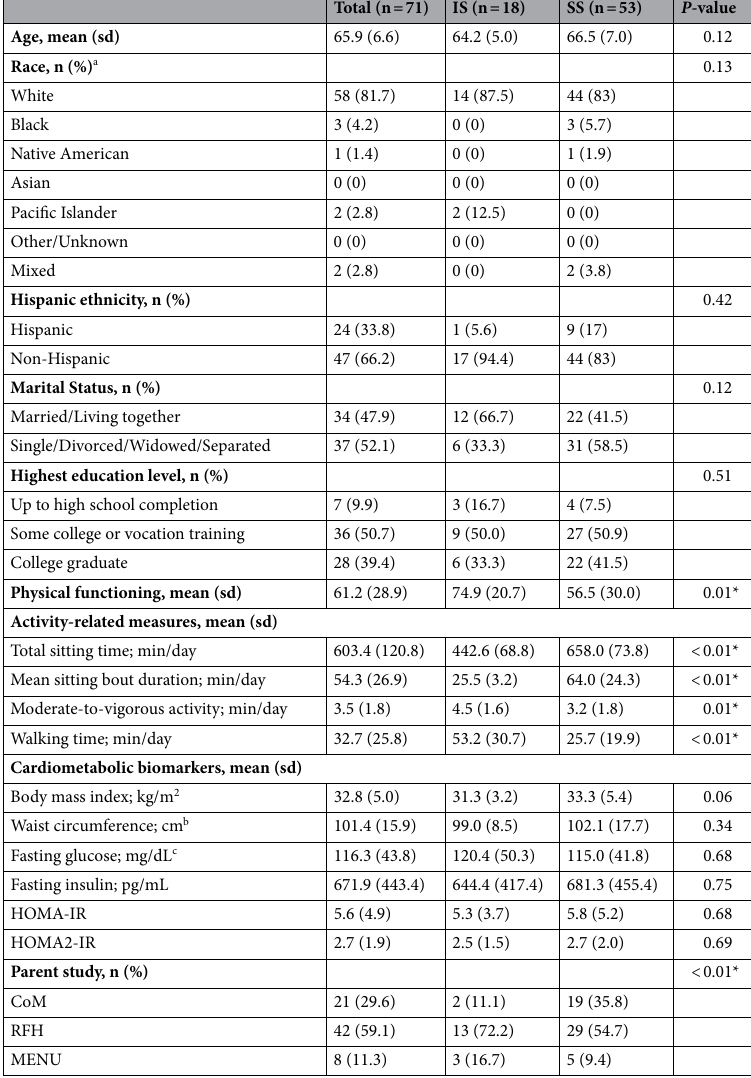
Table 1. Demographics, activity-related measures, and cardiometabolic risk biomarkers of Interrupted Sitters (IS) and Super Sitters (SS). CoM, Community of Mine; RFH, Reach for Health; MENU, Metabolic, Exercise and Nutrition at University of California, San Diego; HDL, high-density lipoproteins; HOMA-IR, homeostatic model assessment of insulin resistance; LDL, low-density lipoproteins. P -values computed using Chi-square tests for categorical variables and t-tests for continuous variables. * P < 0.05. a Missing race data from 3 participants in RfH and 2 participants in CoM. b Missing waist circumference data from 2 participants in RfH. c 4 participants in IS and 8 participants in SS had fasting glucose > 125